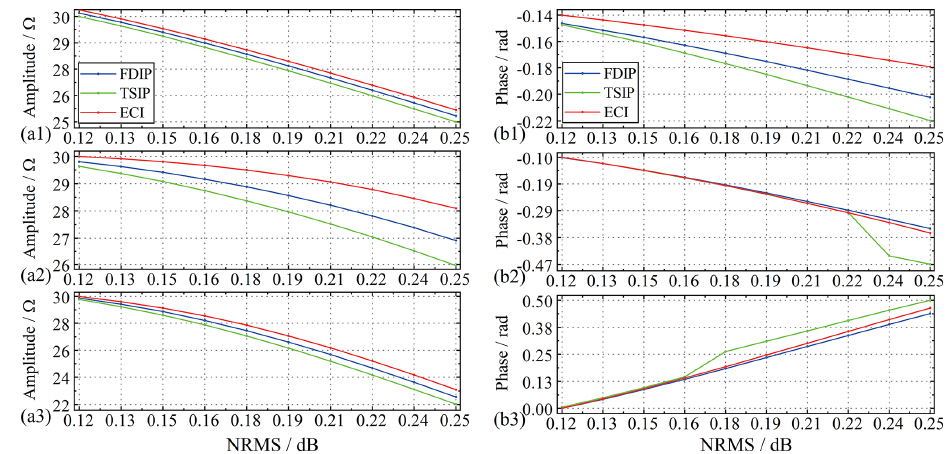
Figure 7. Amplitude and phase of complex resistivity values at (a1, b1) 80Hz, and (a2, b2) 160Hz, (a3, b3) 320Hz using the three methods.